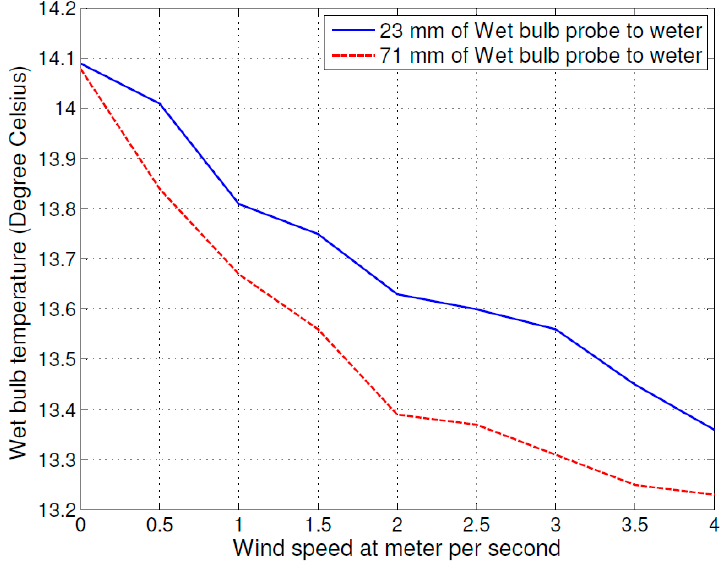
Figure 3. The relation of the air flow speed with wet bulb temperature (cloth size: 126 mm × 122 mm).